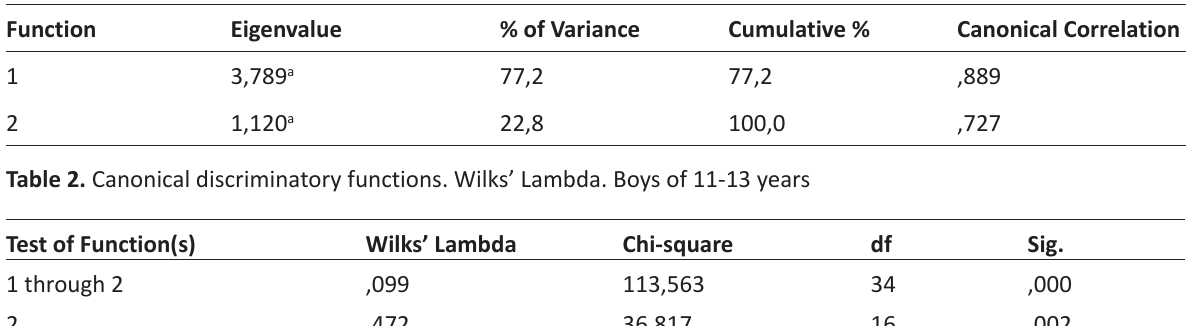
Table 1. Summary of Canonical Discriminant Functions. Eigenvalues. Boys of 11-13 years Function